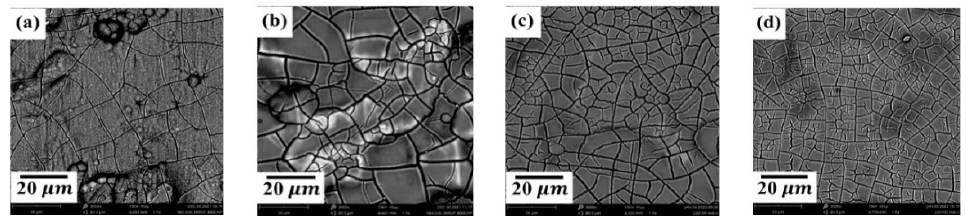
Figure 6. The 90 s chromium conversion treatment, 3000 diameter SEM surface images of Zn–Ni flakes at different NaF concentrations: ( a ) NaF 0%, ( b ) NaF 50%, ( c ) NaF 100%, and ( d ) NaF 150%.